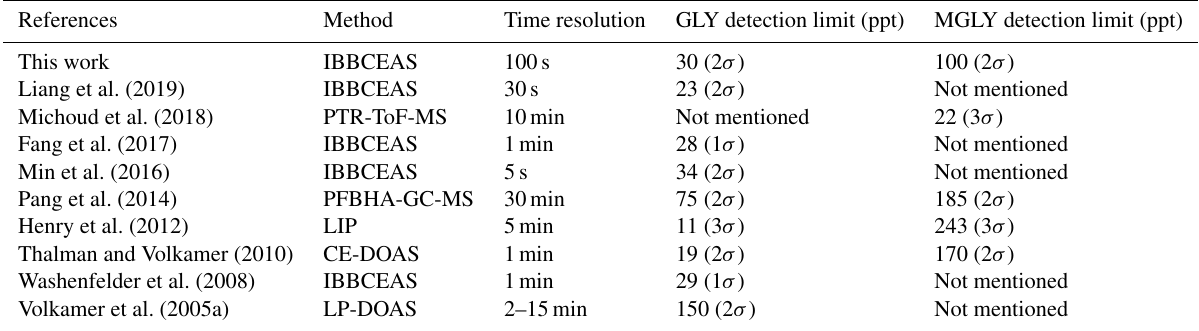
Figure 10. (a) The constant concentration of MGLY produced by the standard gas generator was measured with the NPC on (yellow overlay) and off. The effect of NPC on MGLY concentration is negligible. (b) Well-mixed NO 2 and MGLY were measured with the NPC on (yellow overlay) and off. The concentration of NO 2 dropped while the NPC was running and that of MGLY increased. After the NPC was turned off, their concentrations returned to the same level as before the NPC was turned on. (c) A series of spectra with constant MGLY concentration and increasing NO 2 concentration were simulated and then concentrations of MGLY and NO 2 were calculated by retrieving these simulated spectra. The retrieved MGLY concentration decreased with the increasing NO 2 concentration, although the set value of MGLY concentration in the simulation was kept constant. Table 2. Comparisons of the new IBBCEAS system with other